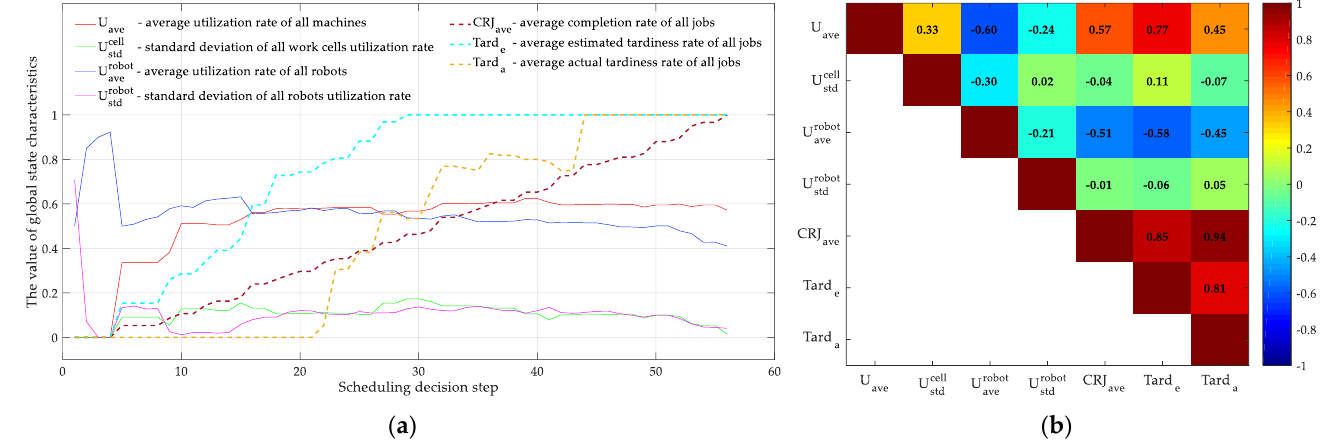
Figure 8. ( a ) Change curve and ( b ) correlation analysis of global state characteristics.